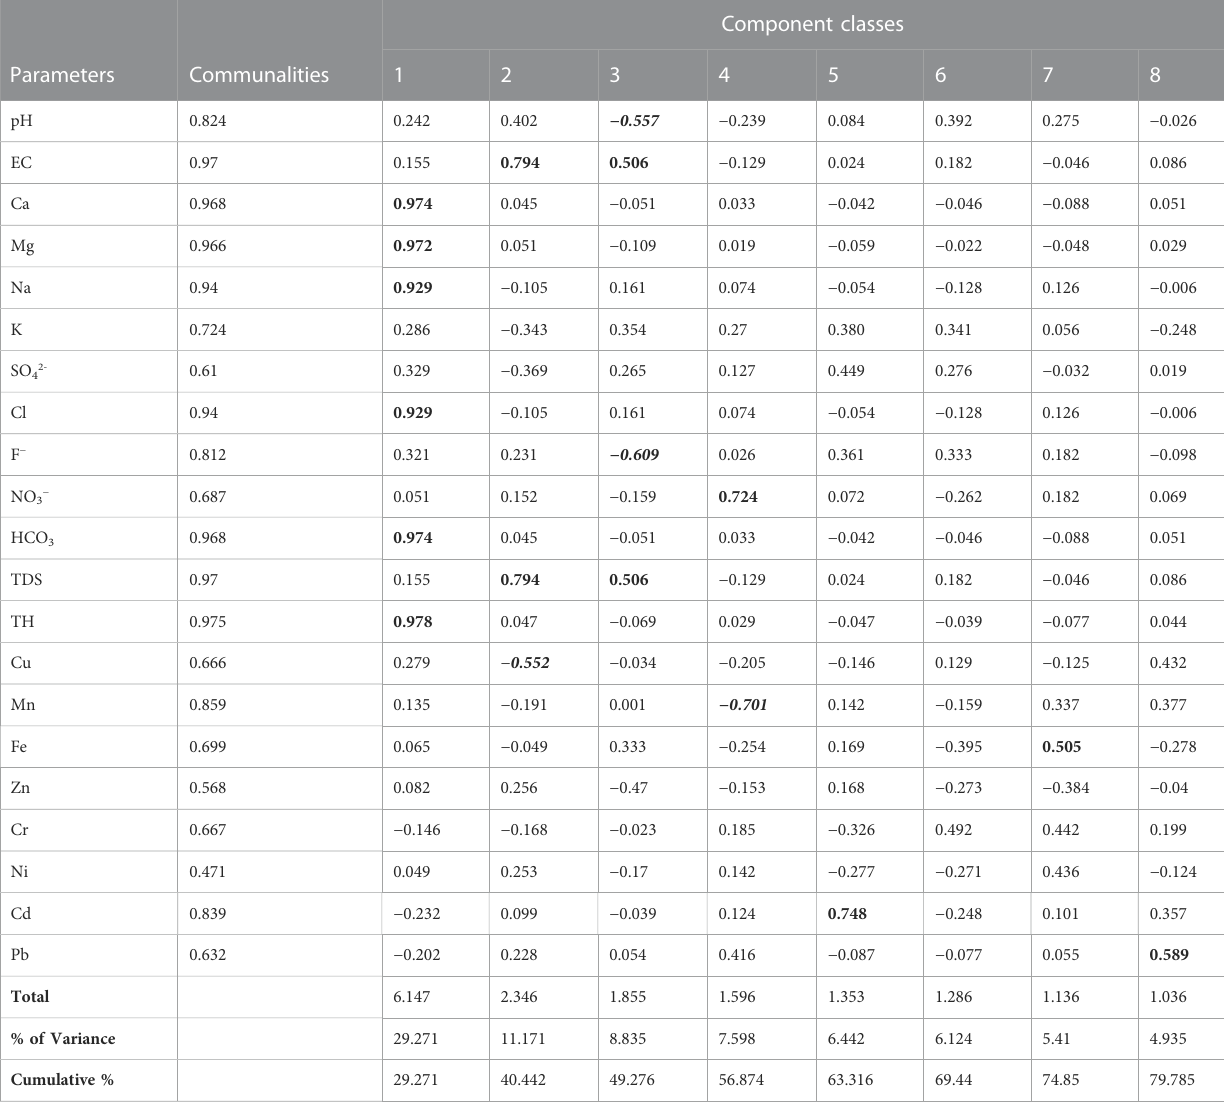
TABLE 11 Unrotated principal component scores for both physicochemical and heavy metals of the analyzed groundwater